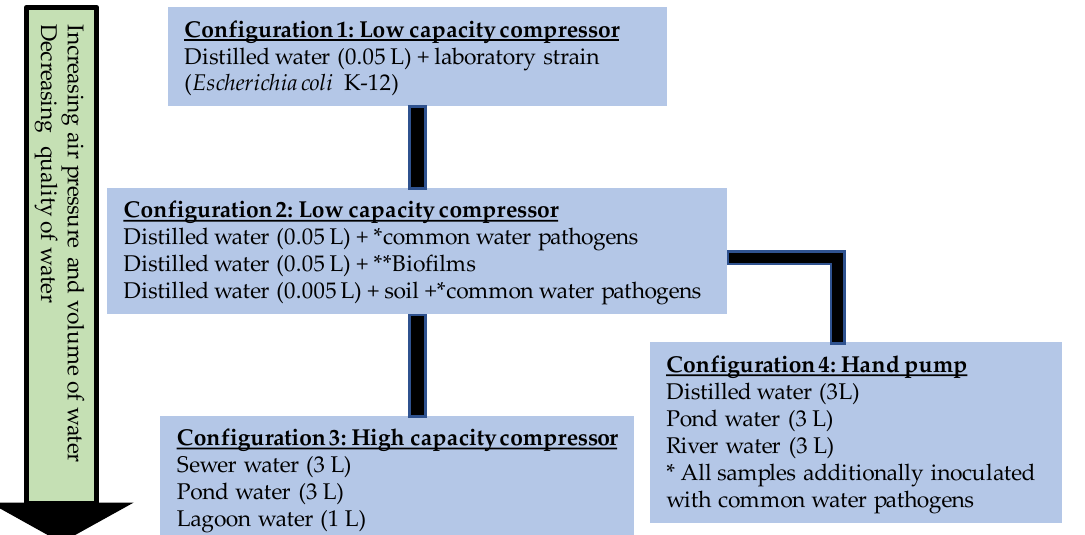
Figure 3. List of experimental setups for the disinfection of bacteria contaminated water using vaporized iodine. Configurations 1 is a proof of concept using water inoculated with a laboratory strain. Configurations 2 to 4 were setup to determine disinfecting e ffi cacy of compressors delivering increasing air pressure and volume of water in disinfecting water of decreasing quality. * Bacterial pathogens tested are Escherichia coli O157:H7, Enterococcus faecalis, Salmonella enterica ** Biofilms composed of Acinetobacter baumannii, Staphylococcus